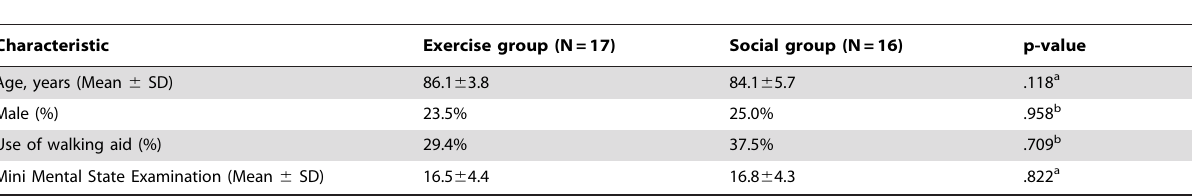
Table 1. Baseline characteristics of the Exercise group and the Social